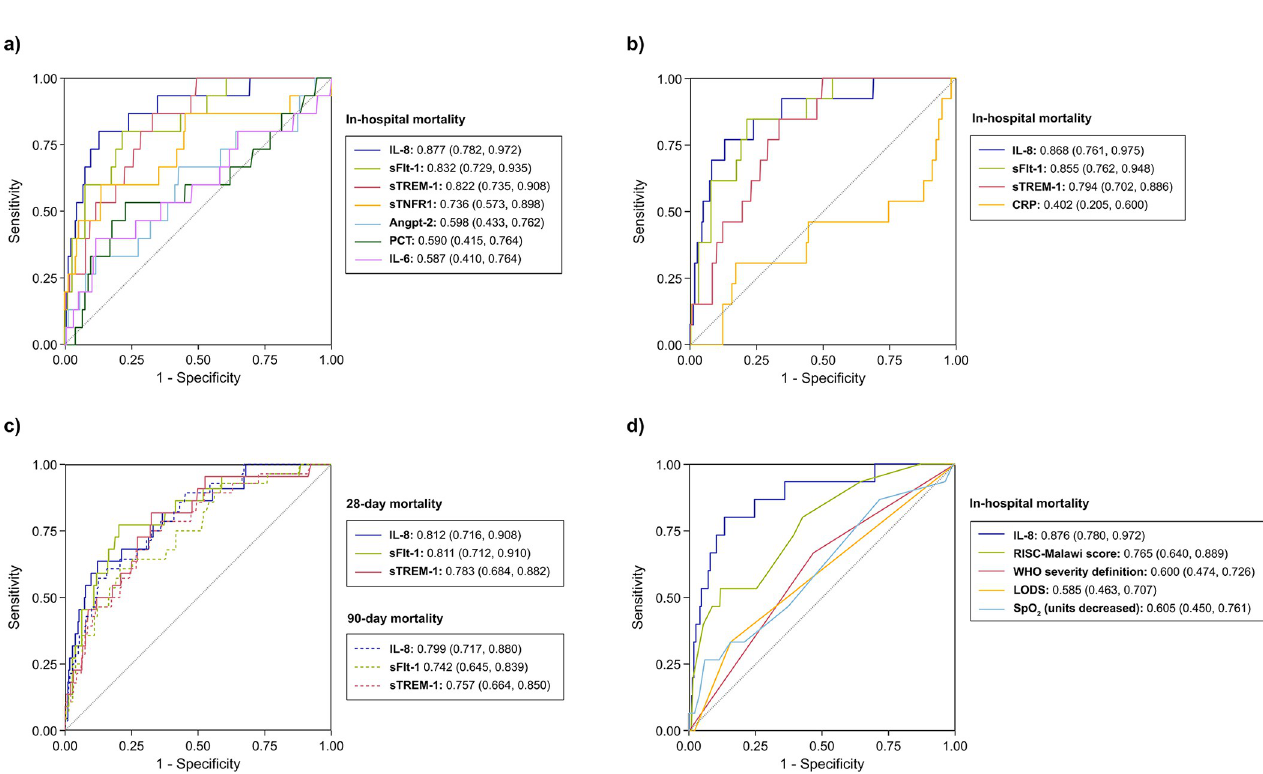
Fig 2. AUROCs of immune and endothelial activation biomarkers and clinical parameters. (A) IL-8, sFlt-1, sTREM-1, sTNFR1, Angpt-2, PCT, and IL-6 AUROCs for in-hospital deaths (n = 432). (B) IL-8, sFlt-1, sTREM-1, and CRP AUROCs for in-hospital deaths (n = 421). (C) IL-8, sFlt-1, and sTREM-1 AUROCs for 28-day and 90-day mortality (in-hospital & post-discharge) (n = 309). (D) IL-8 and clinical parameters AUROCs for in-hospital deaths (n = 405). Abbreviations: Angpt-2 (angiopoietin-2), AUROC (area under the receiver operating characteristic curve), CRP (C-reactive protein), IL-6 (interleukin-6), IL-8 (interleukin-8), LODS (Lambare´ne´ Organ Dysfunction Score), PCT (procalcitonin), RISC-Malawi (Respiratory Index of Severity in Children-Malawi), sFlt-1 (soluble fms-like tyrosine kinase-1), sTNFR1 (soluble tumor necrosis factor receptor), sTREM-1 (soluble triggering receptor expressed on myeloid cells 1), WHO (World Health